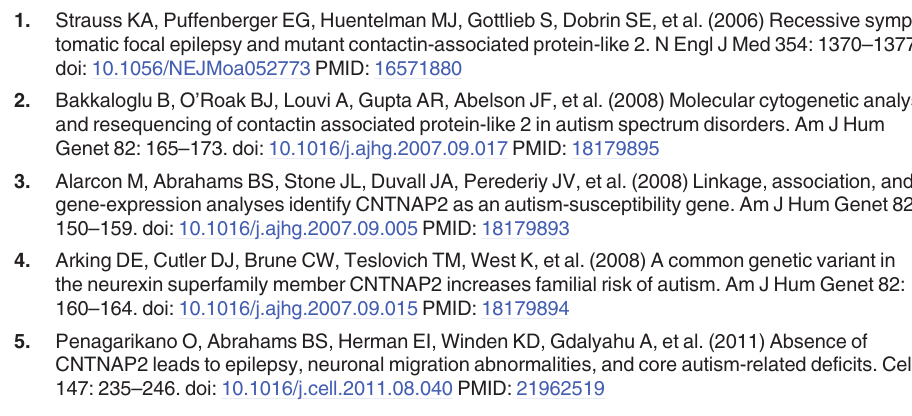
S6 Table. The inheritance patterns at all genes of singleton mutations regarded as deleteri- ous. S7 Table. Overall rare mutation burden in CNTNAP2 in cases and controls in this discovery set, the 2008 data as reported in Bakkaloglu et al., and the Baylor-Broad data. S8 Table. Deleterious singleton mutation burden in CNTNAP2 in cases and controls in this discovery set, the 2008 data as reported in Bakkaloglu et al., and the Baylor-Broad